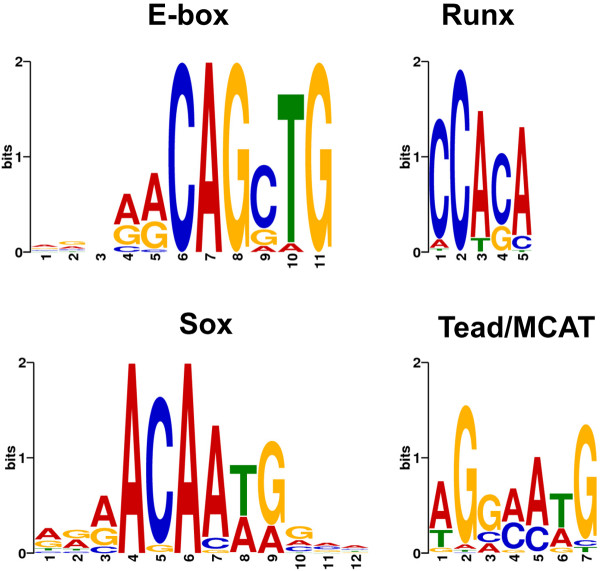
Transcription factor consensus motifs found in Sox6 binding peaks.